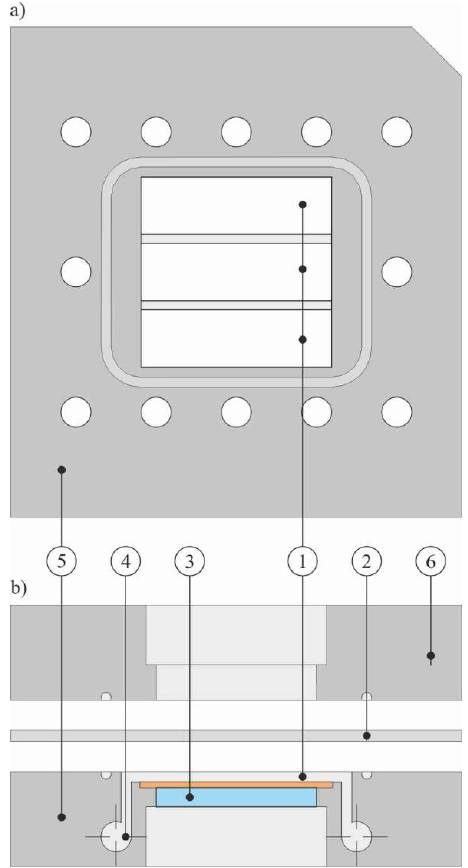
Figure 2. A schematic diagram of the test section with three minichannels: ( a ) view, ( b ) transverse cross-section; (1) a group of three minichannels, (2) a heated foil, (3) a glass panel, (4) inlet/outlet collector, (5) a channel body, (6) a front cover.